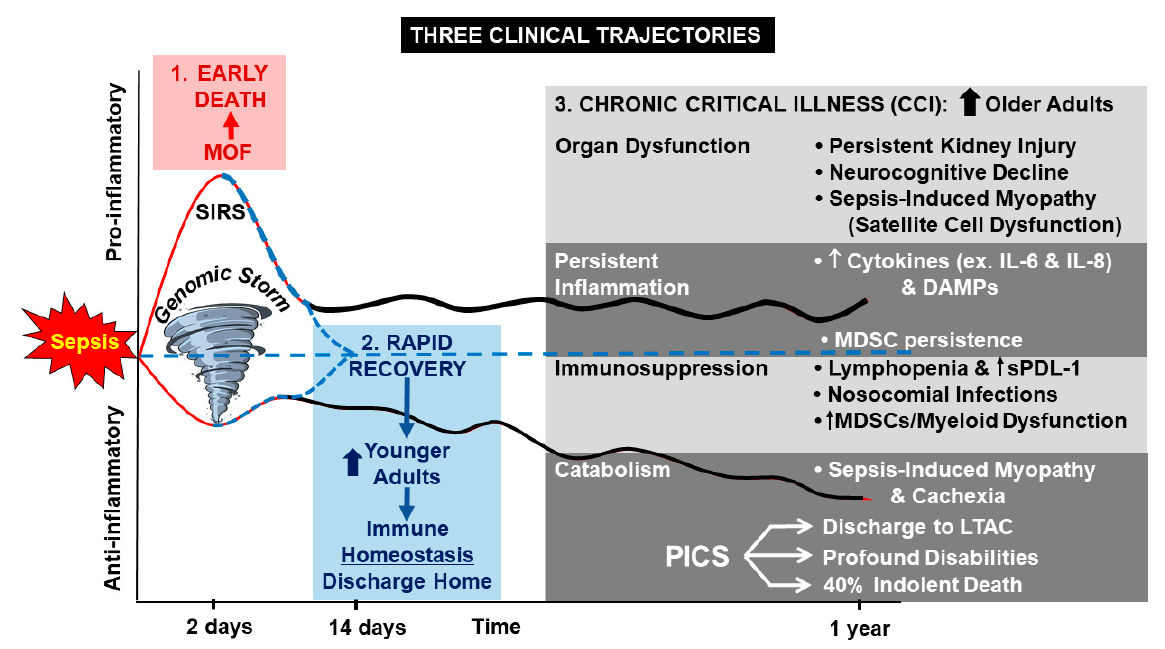
Figure 1. Proposed hypothesis for Persistent Inflammation, Immunosuppression, and Catabolism Syndrome (PICS) in sepsis survivors. Abbreviations: MDSC—myeloid-derived suppressor cell; DAMP—damage-associated molecular protein; LTAC—long-term acute care facility.